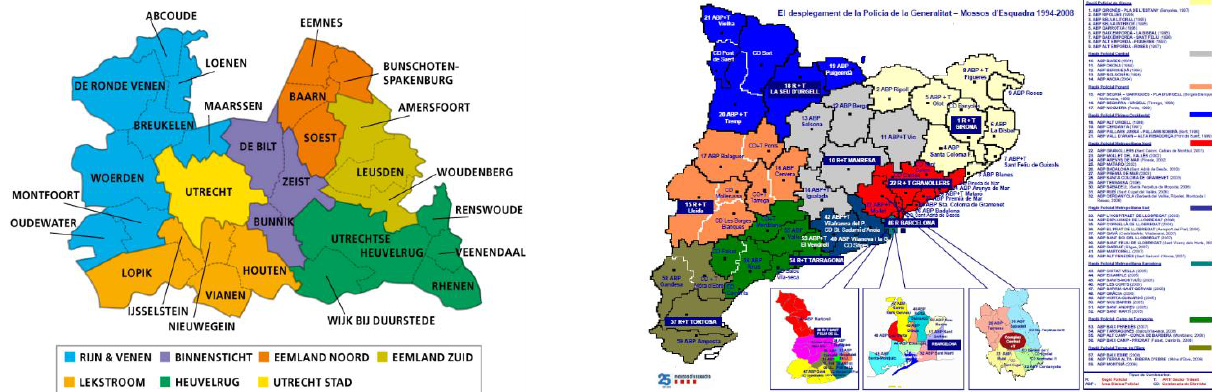
Figure 1. The areas of jurisdiction of the Politie Utrecht and the Mossos d’Esquadra in